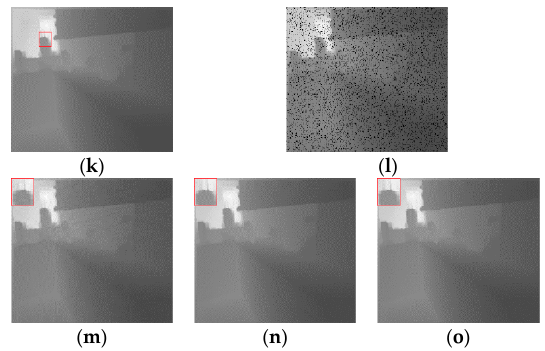
Figure 5. Visual quality comparison of the inpainting result (2): ( a ) Bedroom depth image; ( b ) Corrupted bedroom depth image with 10% pixels missing;( c )–( e ) Inpainting effects of the NNM algorithm, WSNM algorithm and the proposed algorithm; ( f ) Lamp depth image; ( g ) Corrupted lamp depth image with 10% pixels missing;( h )–( j ) Inpainting inpainting effects of the NNM algorithm, WSNM algorithm and the proposed algorithm;( k ) Kitchen depth image;( l ) Corrupted kitchen depth image with 10% pixels missing;( m )–( o ) Inpainting effects of the NNM algorithm, WSNM algorithm and the proposed algorithm.